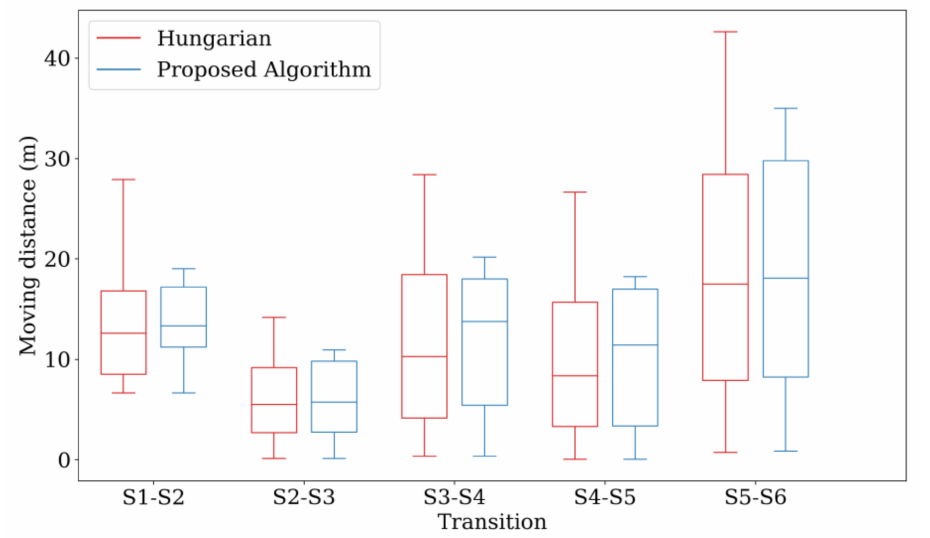
Figure 21. Results of the improved Hungarian method.